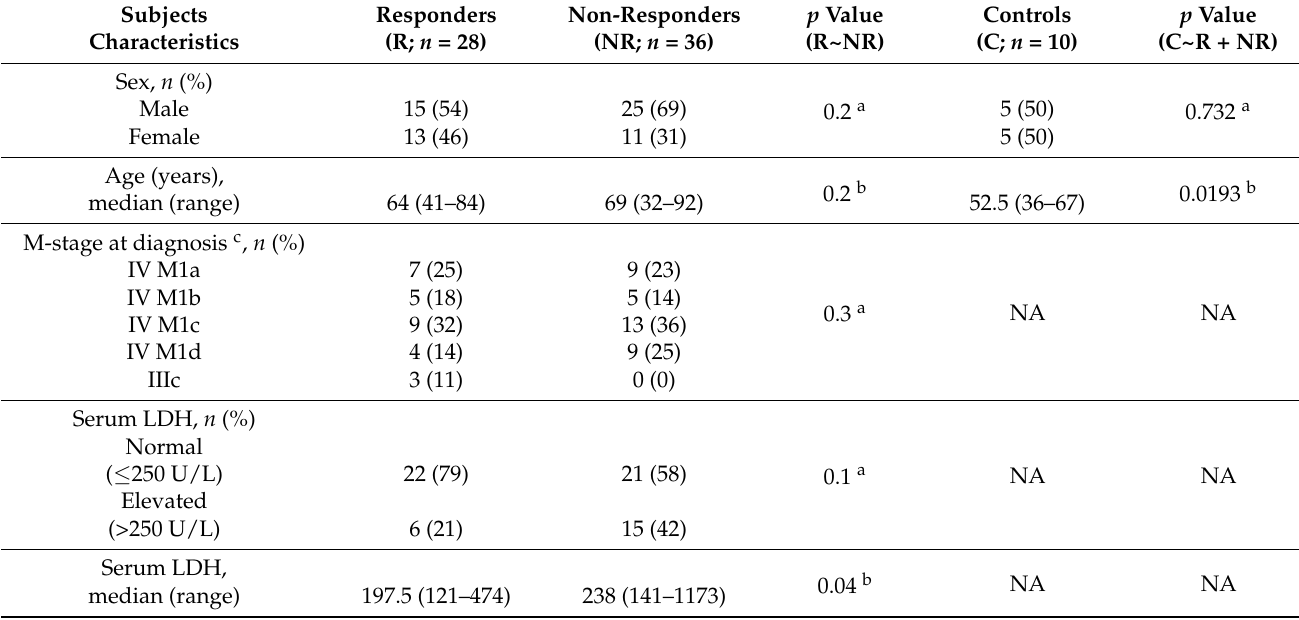
Table 1. Baseline characteristics of all ICI patients and healthy subjects ( n =